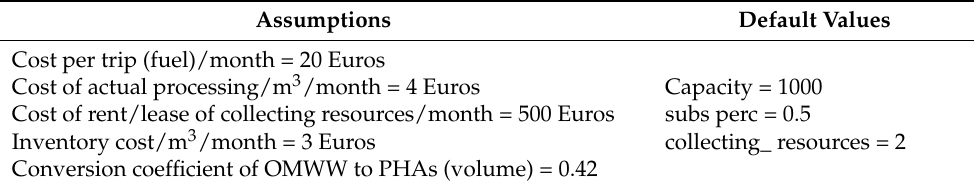
Table 6. Assumptions and default values for model simulations.